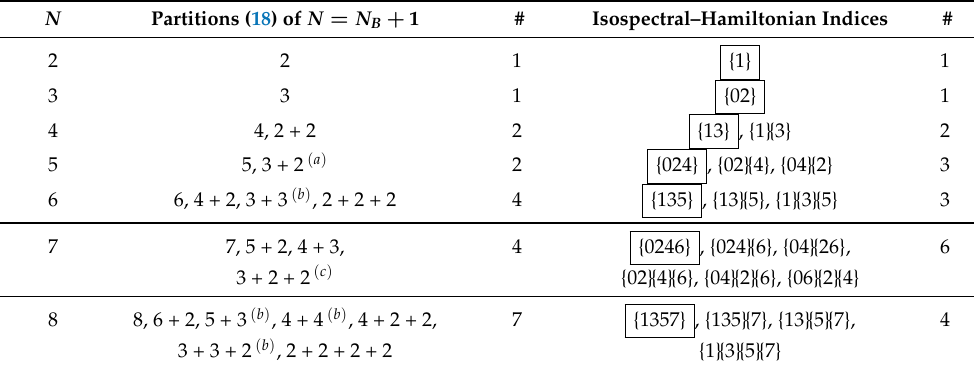
Table 5. The first few generalized BH models in the alternative notation of Section 6.2 (the trivial, tridiagonal-matrix BH items of Equation (6) are